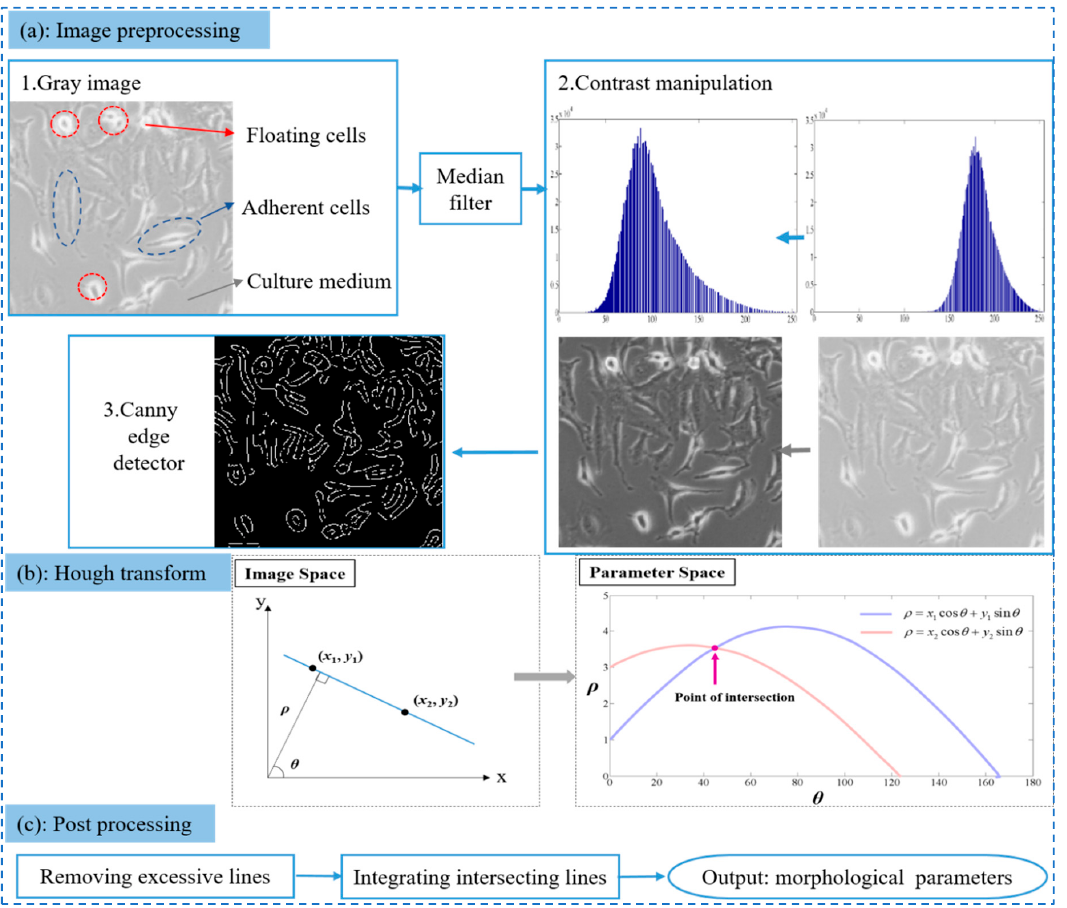
Figure 1. The framework of the digital image process. ( a ) Image preprocessing includes gray transformation, median filter, contrast manipulation, and canny edge detection; ( b ) Hough transform (HT) demonstrates the transformation between image space and parameter space; and ( c ) post- processing includes removing excessive lines and integrating intersecting